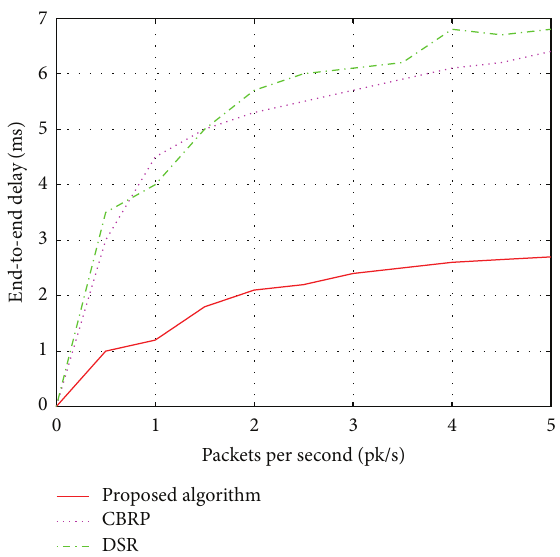
Figure 6: Swarm structure stability over time for the proposed, CBRP, and DSR protocols.